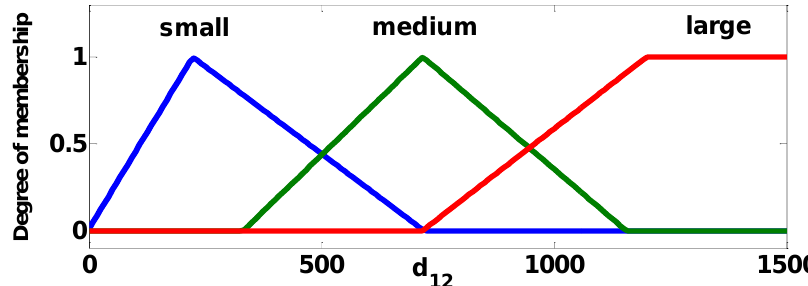
Figure 12. The structure of the fuzzy voter.